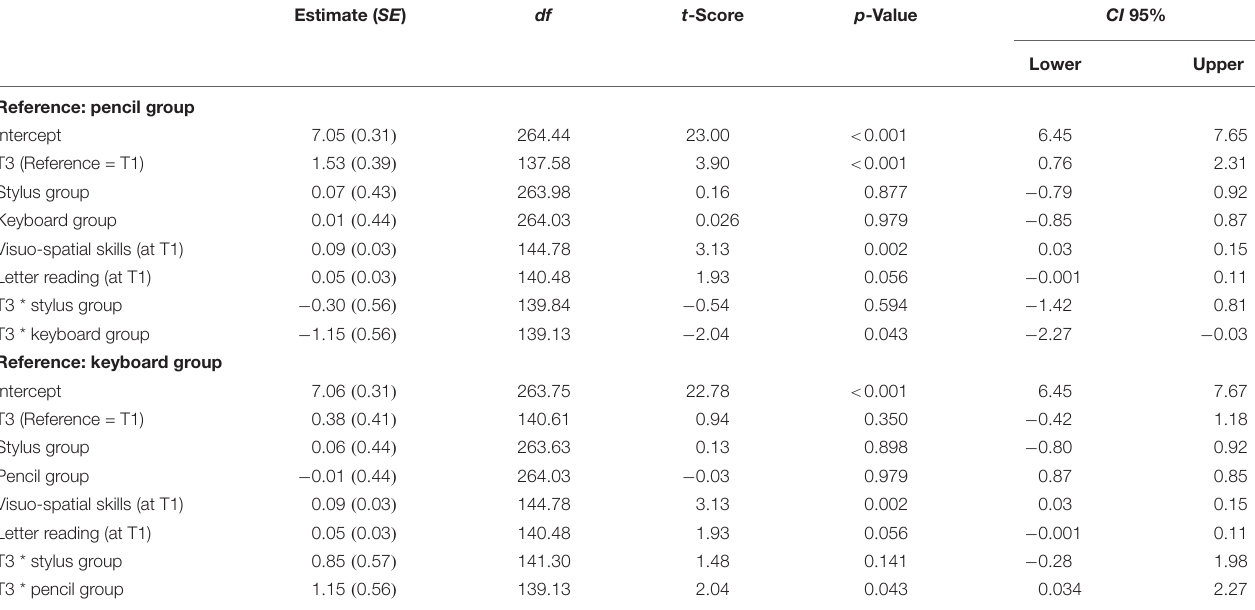
TABLE 4 | Results of estimated LMMs for the variable letter recognition to T1 vs. T3. Estimate ( SE ) df t -Score p -Value CI 95%